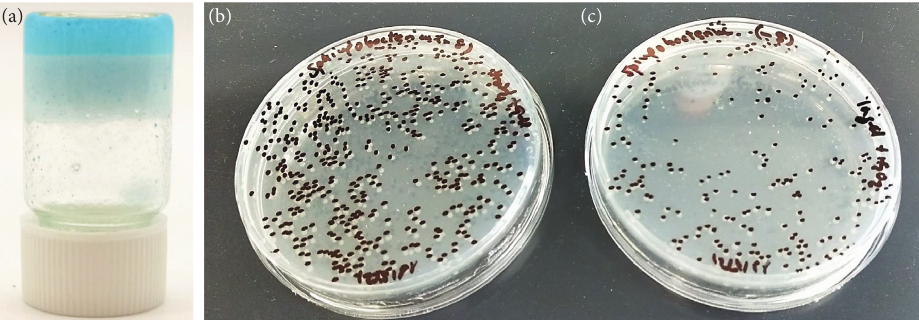
Figure 10: Photographs of 1n@Gelatin (a) and Sphingobacterium spiritivorum colony count method (50 μ L of overnight of culture after 10 − 8 dilution) (b) where 490 colonies were counted for the blank experiment (40 µ L of H 2 O 2 at 25 mM) and (c) 210 colonies were counted after being treated Sphingobacterium with 1n@Gelatin (40 µ L at 3 mg/mL) plus H 2 O 2 (40 µ L at